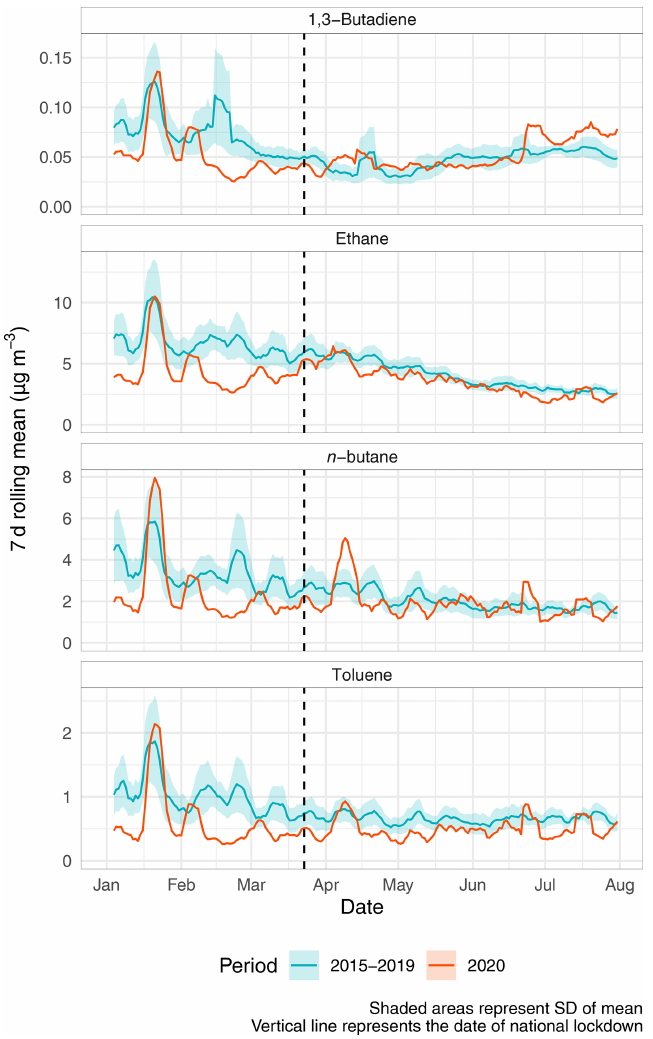
Figure A3. Time series of volatile organic compounds (VOCs) at London Eltham, an urban background site in the United Kingdom.